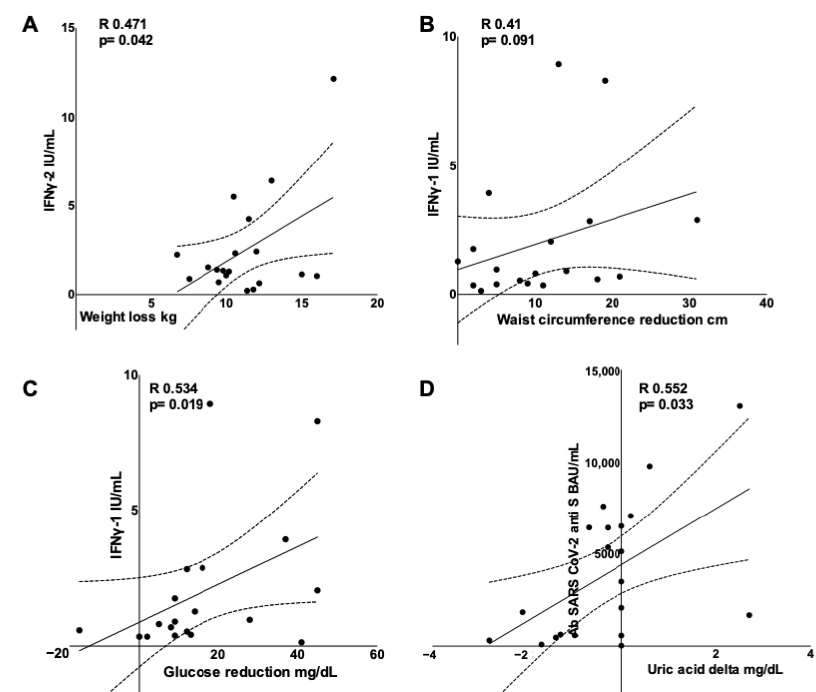
Figure 2. Scatterplots showing that metabolic improvement on dieting is directly correlated with the adaptive immune response after an mRNA COVID-19 vaccination. IFNγ-1 loss is directly cor- related with ( A ) weight loss, ( B ) waist circumference reduction (trend) and ( C ) glucose reduction, while anti SARS CoV-2 antibodies are directly correlated with uric acid change ( D ).